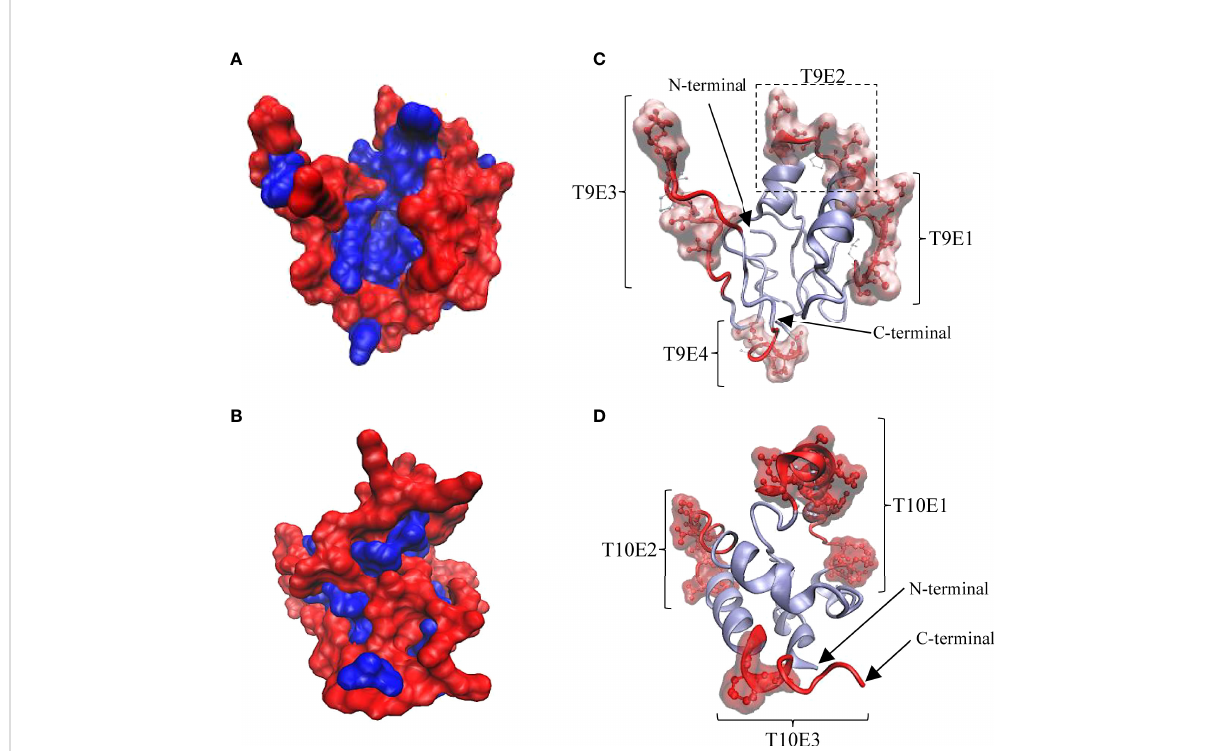
FIGURE 5 3D structure of Tis9 and Tis10 proteins showing their surface polarity, linear and conformational B cell epitope regions and relative proportions of amino acid residues in conformational epitopes. (A) Tis9 and (B) Tis10 models are shown in surface presentation, nonpolar residues (blue) buried in the core, whereas polar residues (red) tend to occur at the surface of proteins. (C and D) Predicted linear epitope and conformational epitope from the ElliPro results. Polar surface regions in (A) and (B) displayed linear epitopes (represented as red ribbon) and conformational epitopes (represented as red CPK along with surface structure on the Tis9 (C) and Tis10 (D) models. Their N-terminus and C-terminus are indicated by arrows.